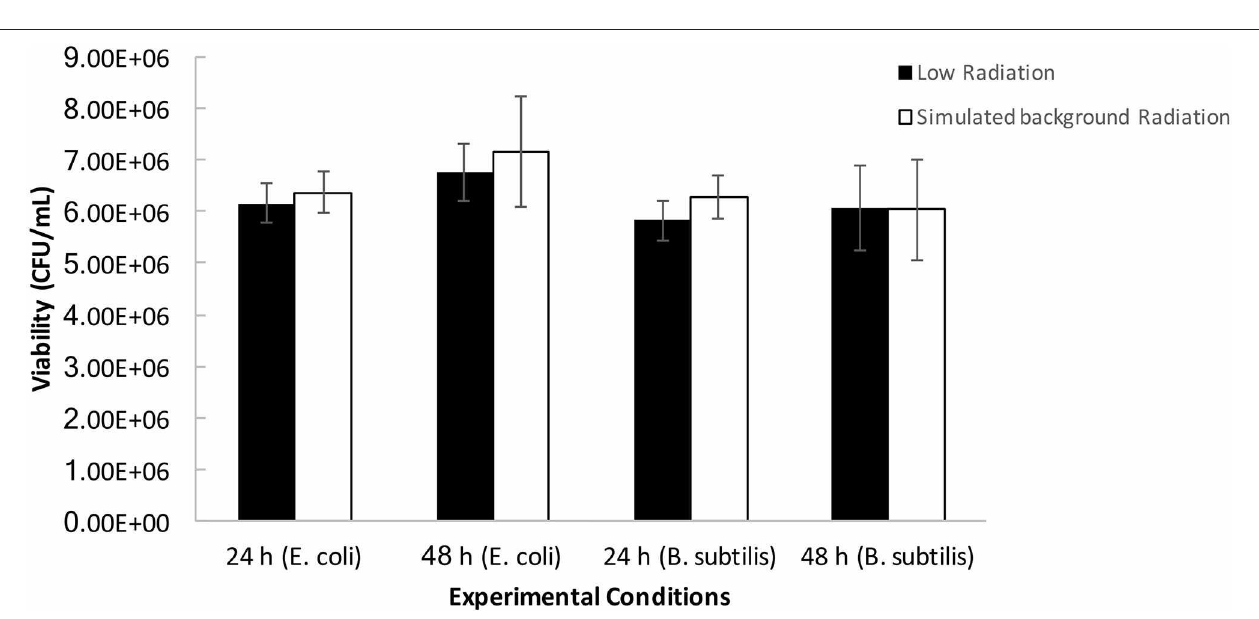
FIGURE 7 | Averages ( n = 9 per condition) of post-UV irradiation cell counts of B. subtilis and E. coli grown under the determined low radiation (“low”) and artificial background radiation (“sim. background”) dose rate: 24 and 48h denote time in hours that bacteria batch has spent in respective conditions. Error bars show ± standard error ( n = 9 per